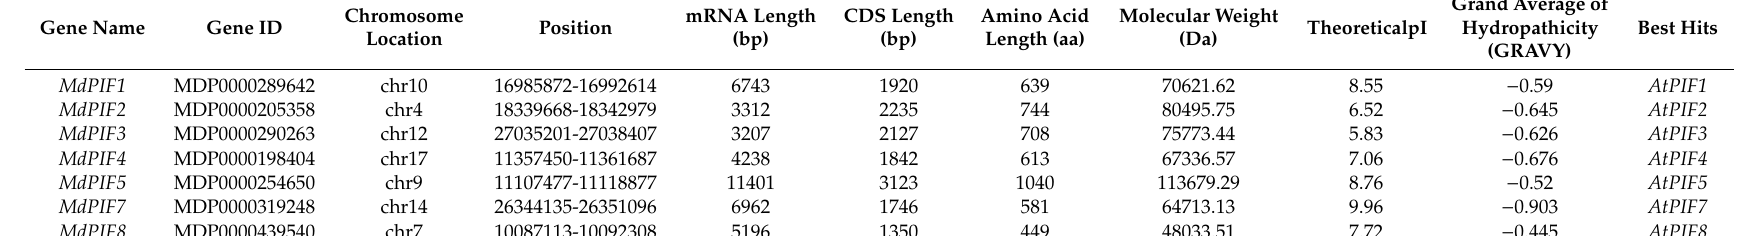
Table 1. Information about the PIF members found in apples.